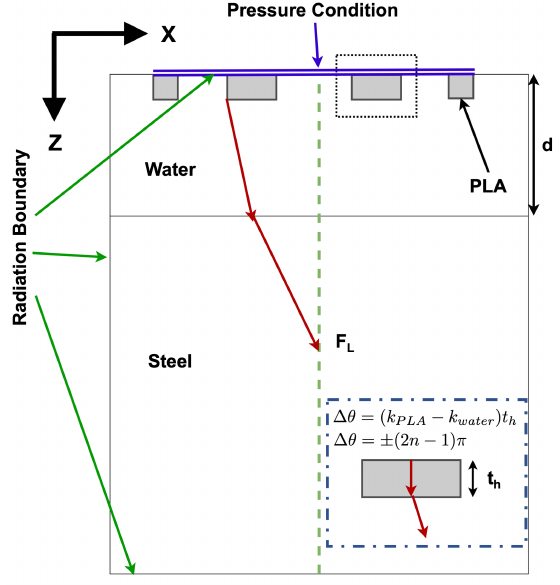
Figure 3. Finite elements method (FEM) Scheme of the implemented numerical